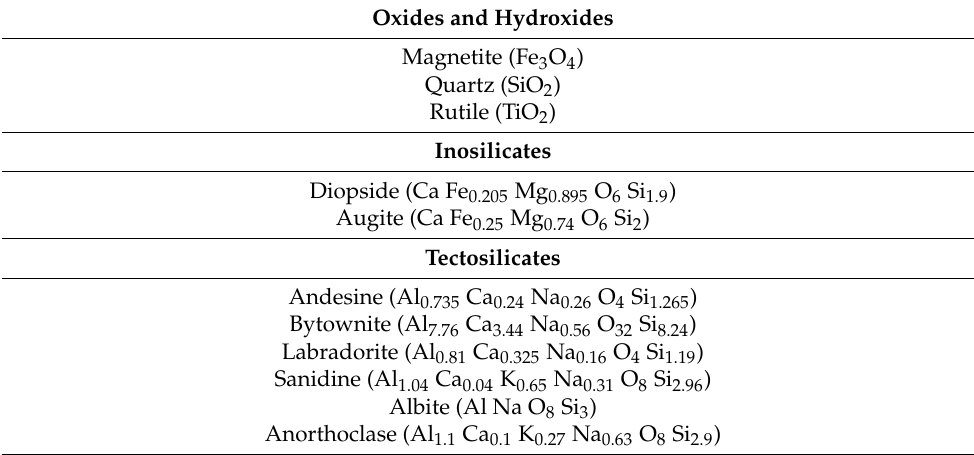
Table 3. Mineralogical phases in volcanic materials.